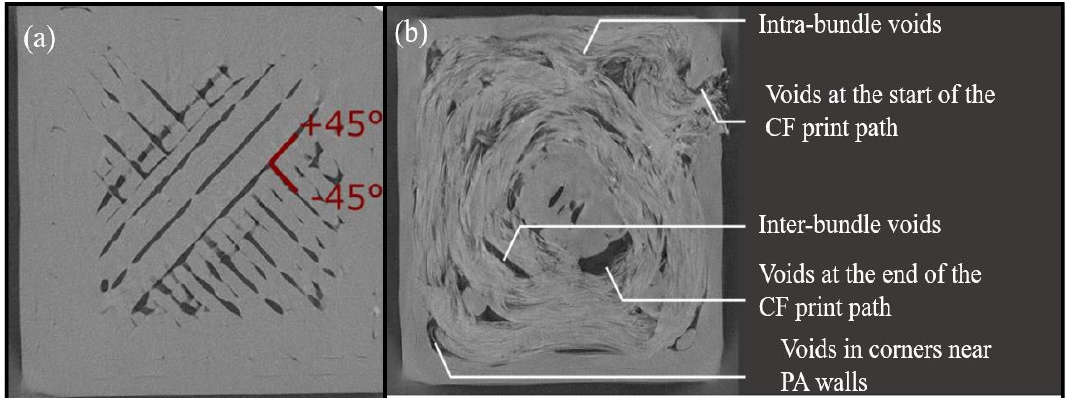
Figure 13. ( a ) Cross ‐ section of continuous CF reinforced filament. ( b ) Magnified image representing voids between fibres [202].